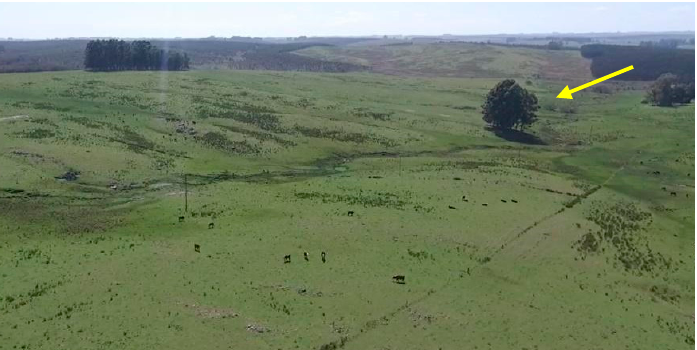
Figure 3. A picture of one of the open pasture systems (OPS) under study, showing a small plot of trees (see yellow arrow).